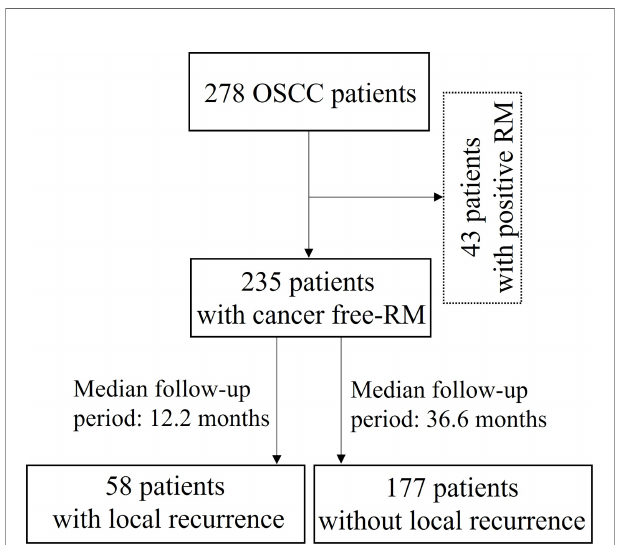
FIGURE 1 | Flow diagram for the selection and outcome of patients with oral squamous cell carcinoma (OSCC: Oral squamous cell carcinoma; RM: Resection